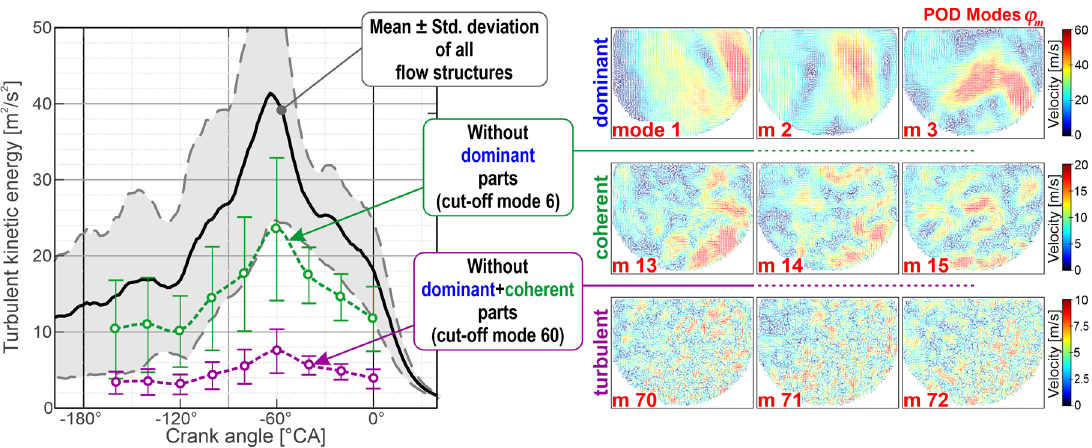
Figure 17. Crank angle dependent turbulent kinetic energy in the combustion chamber of the Flex-OeCoS for the standard measurement conditions (600 rpm / 100 bar). Shown are the overall values that contain all flow structures and the reduced values after the subtraction of the dominant structures or the dominant and coherent flow structures. The modes have been calculated with the Proper Orthogonal Decomposition Method